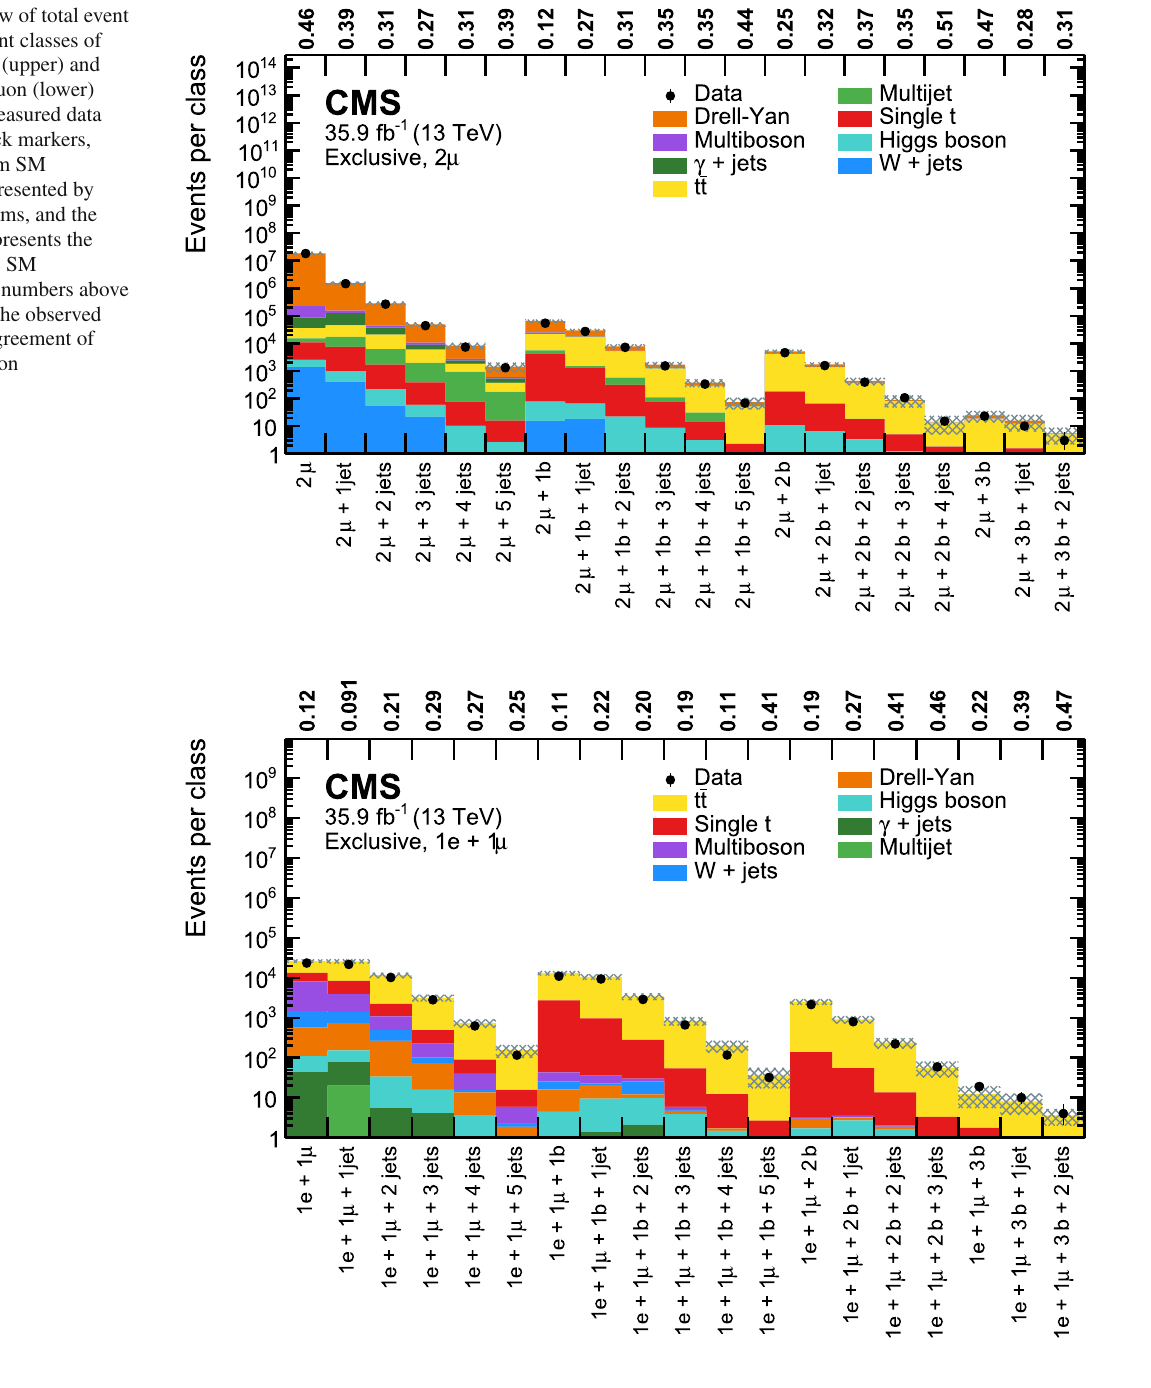
Fig. 15 Overview of total event yields for the event classes of the double-muon (upper) and the electron + muon (lower) object groups. Measured data are shown as black markers, contributions from SM processes are represented by coloured histograms, and the shaded region represents the uncertainty in the SM background. The numbers above the plot indicate the observed p value for the agreement of data and